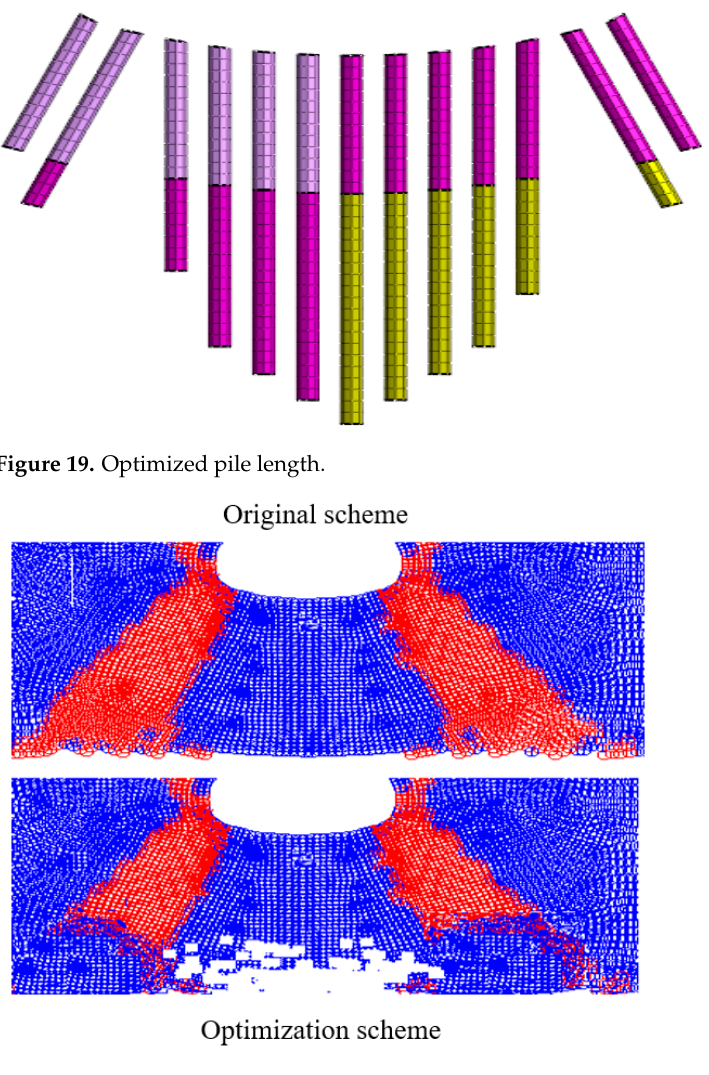
Figure 20. Comparison of the plastic zone before and after optimization.